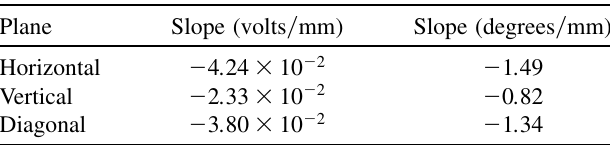
TABLE I. Slope of curves in Fig. 2 when the phase detector used L1:P1 to detect the beam phase. Conversion of volts to degrees was made using the absolute value of the measured negative slope shown in Fig. 2 ( (cid:3) 35 : 2 (cid:1) = volt ).